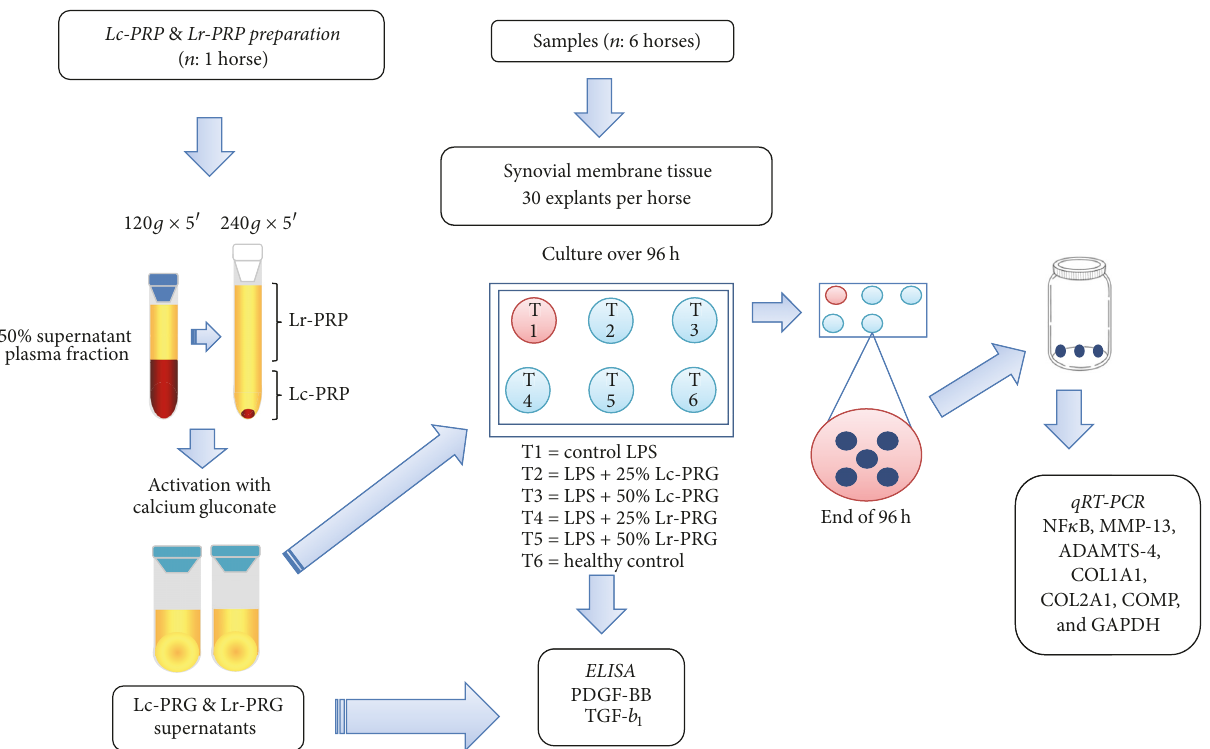
Figure 1: Schematic workflow of the experiments in the